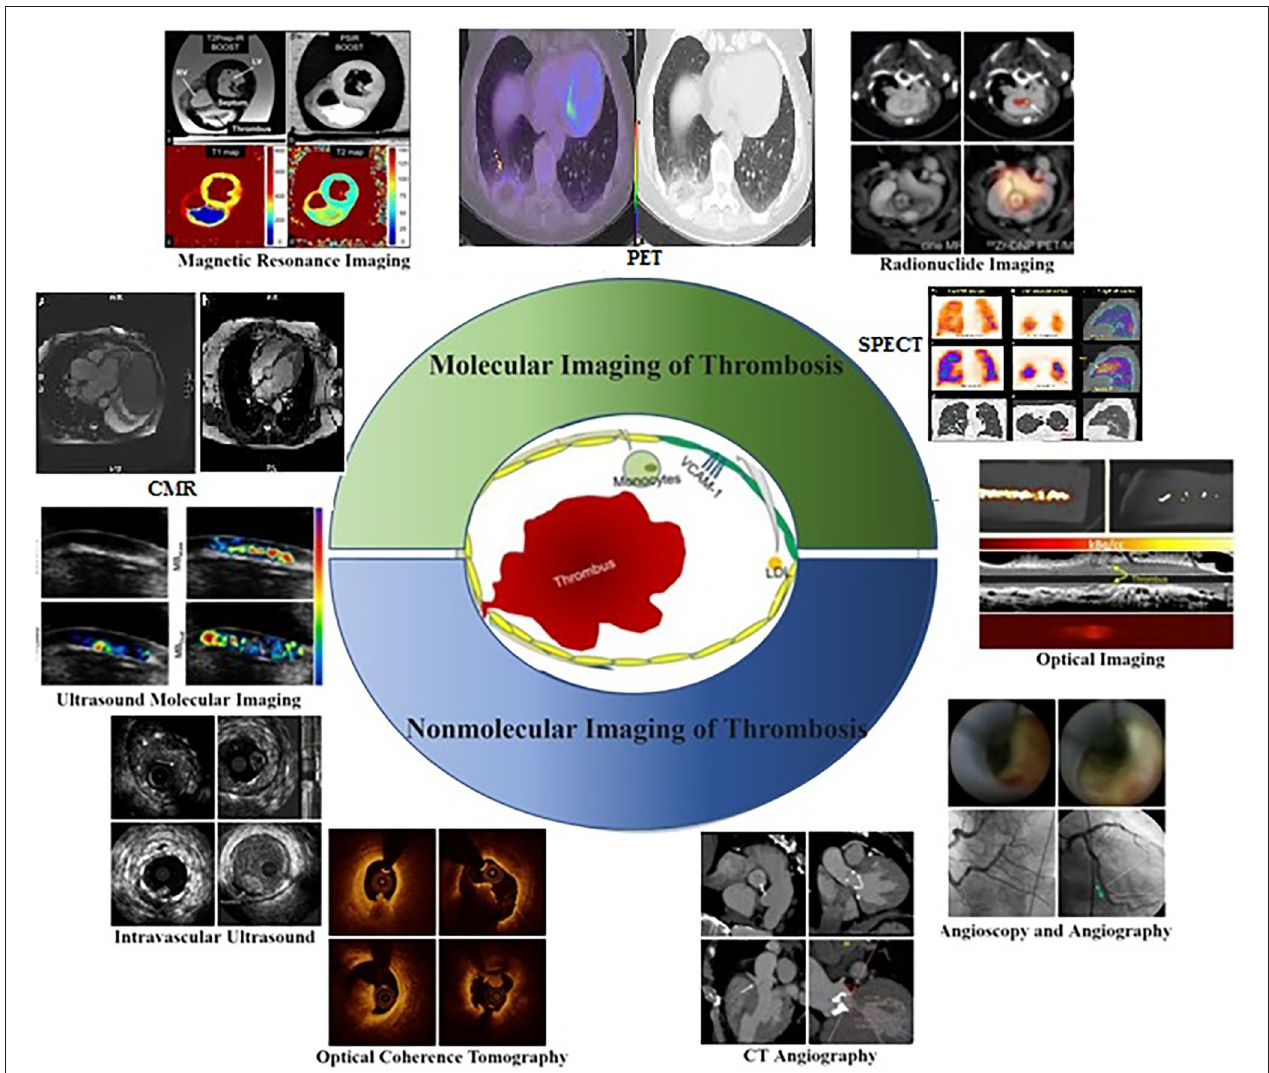
FIGURE 1 | Molecular and Non-molecular thrombosis imaging strategies in atherosclerosis patients for assessing pathophysiological features related to early thrombosis at the molecular and cellular level ( 13), including ultrasound molecular imaging (6), magnetic resonance imaging (7), radionuclide imaging (14), optical imaging (15), intravascular ultrasound, optical coherence tomography, CT angiography (16), angioscopy and angiography